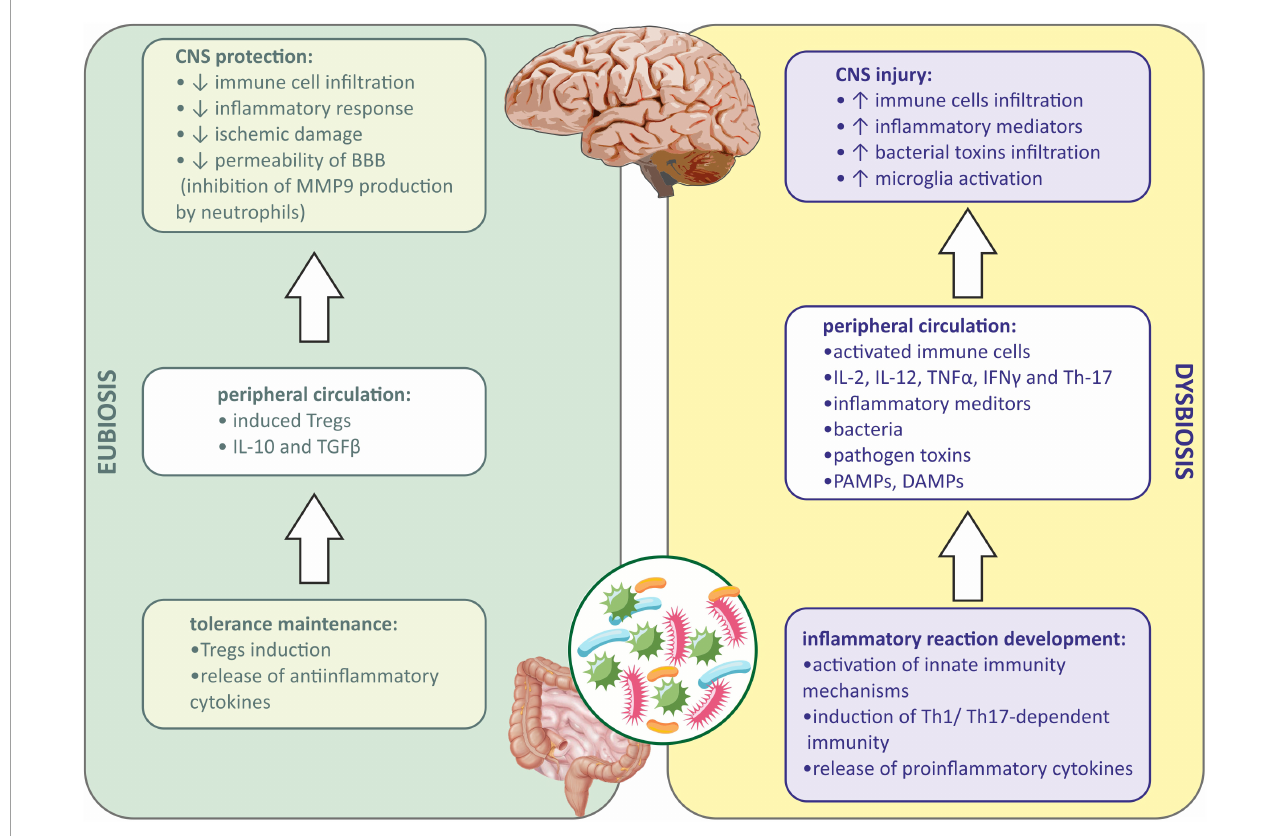
FIGURE1 Immune signaling between gut microbiota and central nervous system during eubiosis and dysbiosis. BBB, blood-brain barrier; CNS, central nervous system; DAMPs, damage-associated molecular patterns; IFN γ , interferon gamma; IL-2, interleukin-2; IL-10, interleukin 10; IL-12, interleukin 12; MMP9, matrix metallopeptidase 9; PAMPs, pathogen associated molecular patterns; TGF β , transforming growth factor β ; Th-1, T helper 1 cells; Th-17, T helper 17 cells; TNF α , tumor necrosis factor α ; Tregs, regulatory T